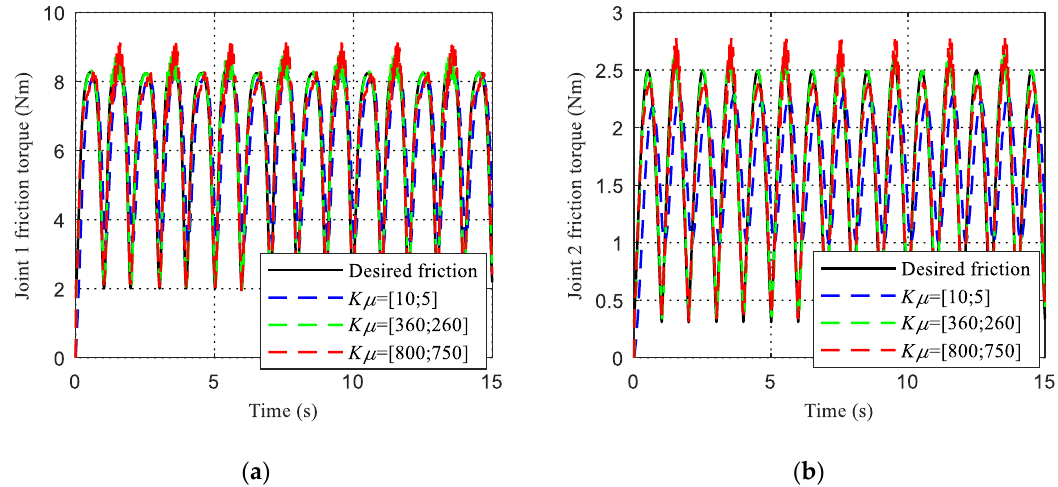
Figure 3. The desired and estimated friction torque disturbance curves of joints 1 and 2 for different values of gain coefficients ( K μ ) . ( a ) Joint 1 curves. ( b ) Joint 2 curves. Table 1. The estimated friction torque errors for different gain coefficients ( K μ ).